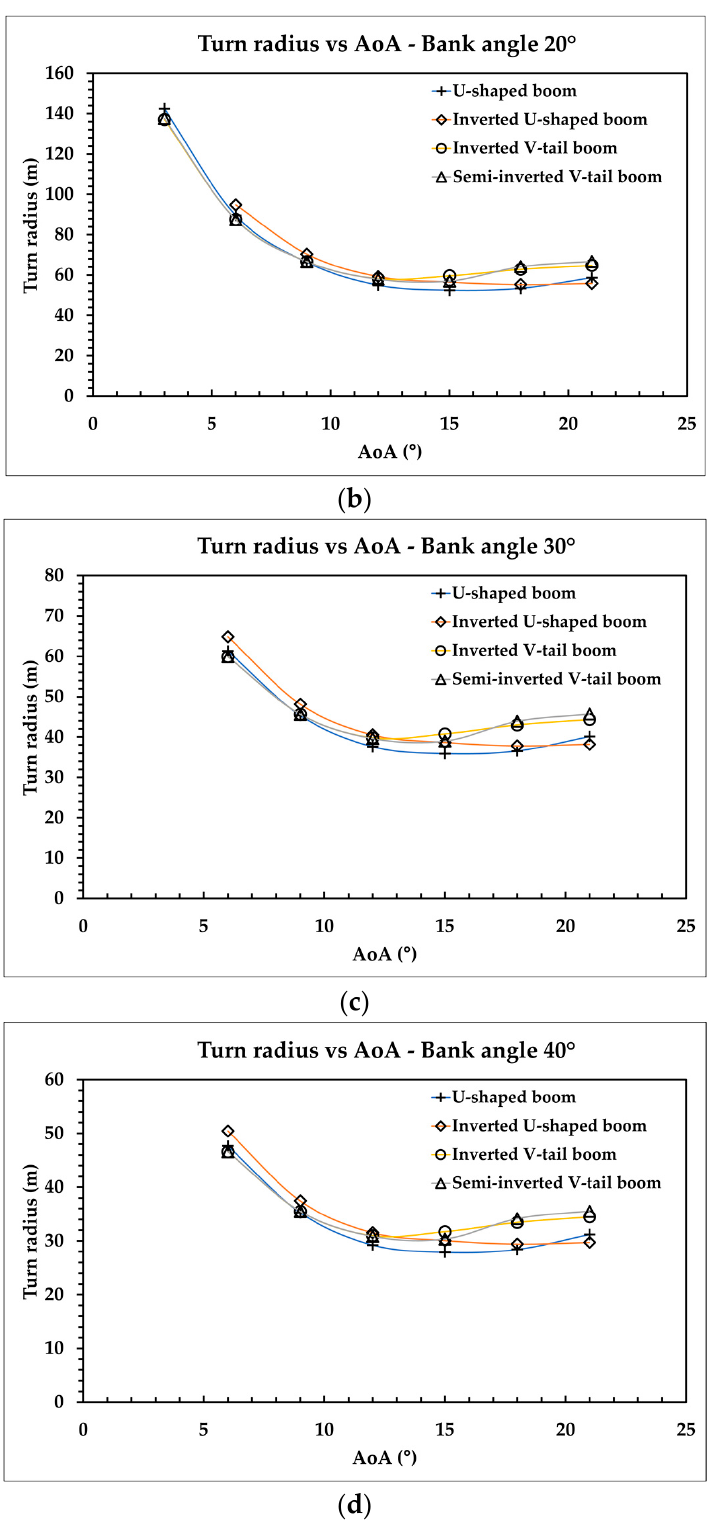
Figure 19. Maneuverability vs. AoA on headwind conditions, bank angle: ( a ) 10°, ( b ) 20°, ( c ) 30°, and ( d ) 40°.